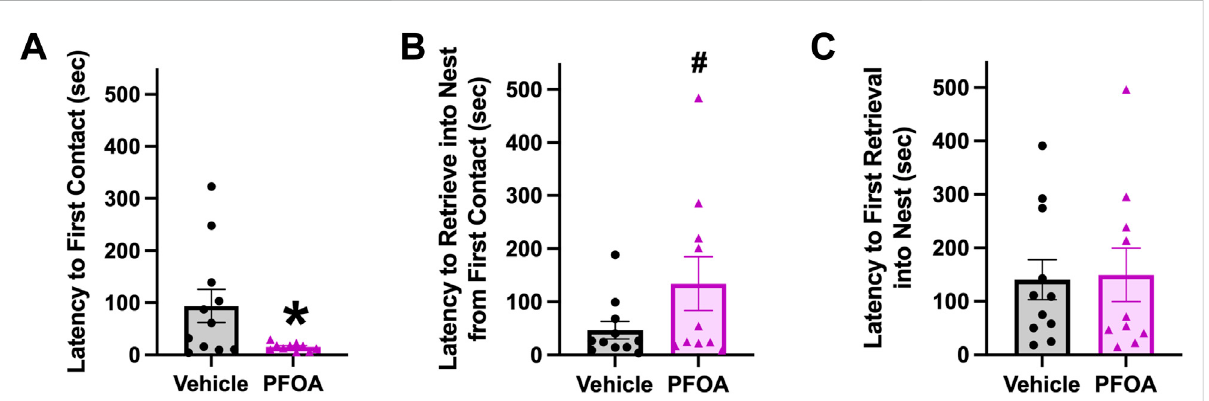
FIGURE 4 PupRetrieval.Pupretrievalwasperformedonpostnatalday5.Latencyto fi rstcontact (A) ,latencyto retrieveintonestfrom fi rstcontact (B) ,and latency to fi rst retrieval into nest (C) were measured. Data shown as mean ± standard error of the mean, n = 10/PFOA and n = 11/vehicle. Data analyzed with two-sided student ’ s t-test. Asterisks means p ≤ 0.05 and number sign means p ≤